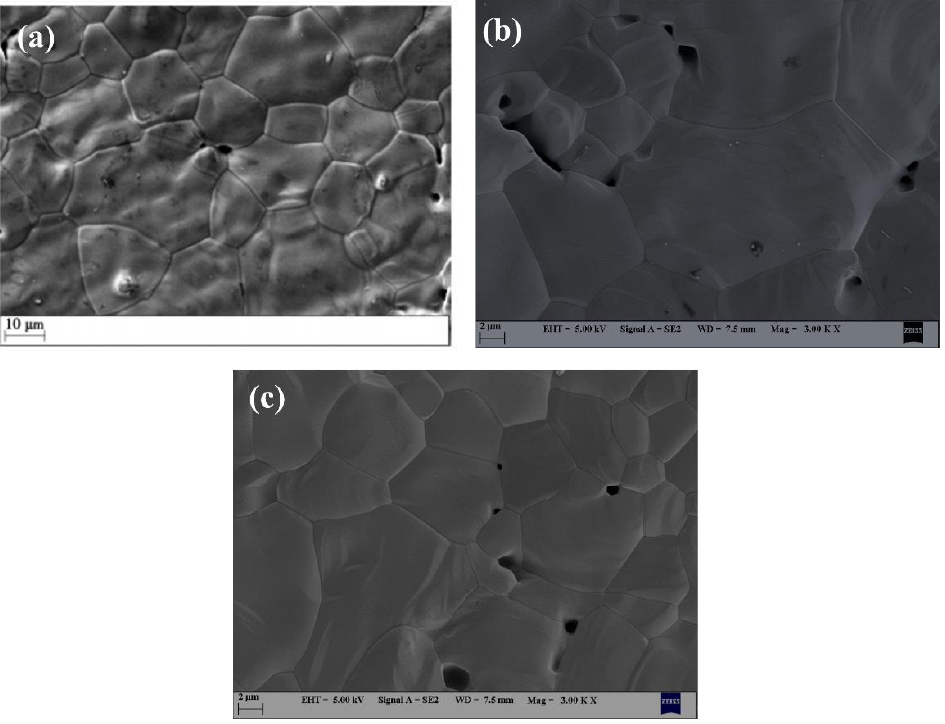
Figure 8. SEM images of the microstructure of UO 2 –graphene sintered pellets with a ( a , b ) graphene content of 8% prepared by physical mixing and ( c ) a graphene content of 4% prepared by in situ synthesis.